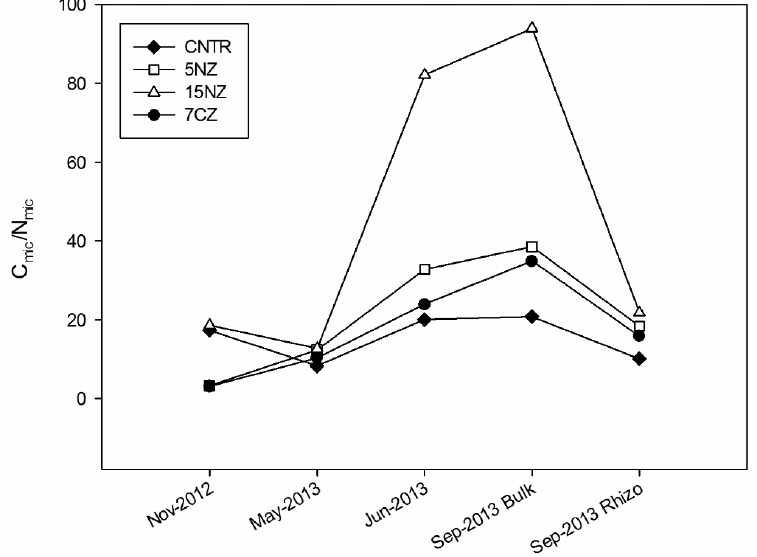
Figure 5. Microbial biomass C/N ratio over the monitoring period. Table 3. C content of Humic Acids (HA) and Fulvic Acids (FA), percentage of Total Extractable and Total Organic Carbon (TEC/TOC) ratio, Humification Index (HI) and Humification Degree (HD) according to Ciavatta et al. [33] and Sequi et al. [34].